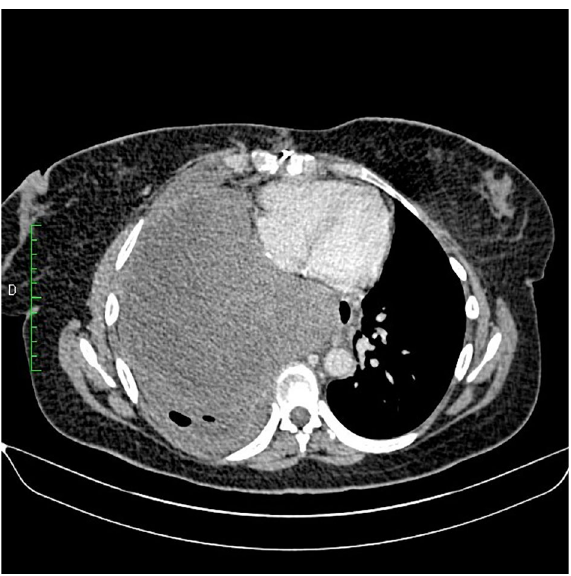
Figure 6. CT (coronal reconstruction): huge relapse of mediastinal mass with cardiac and tracheal